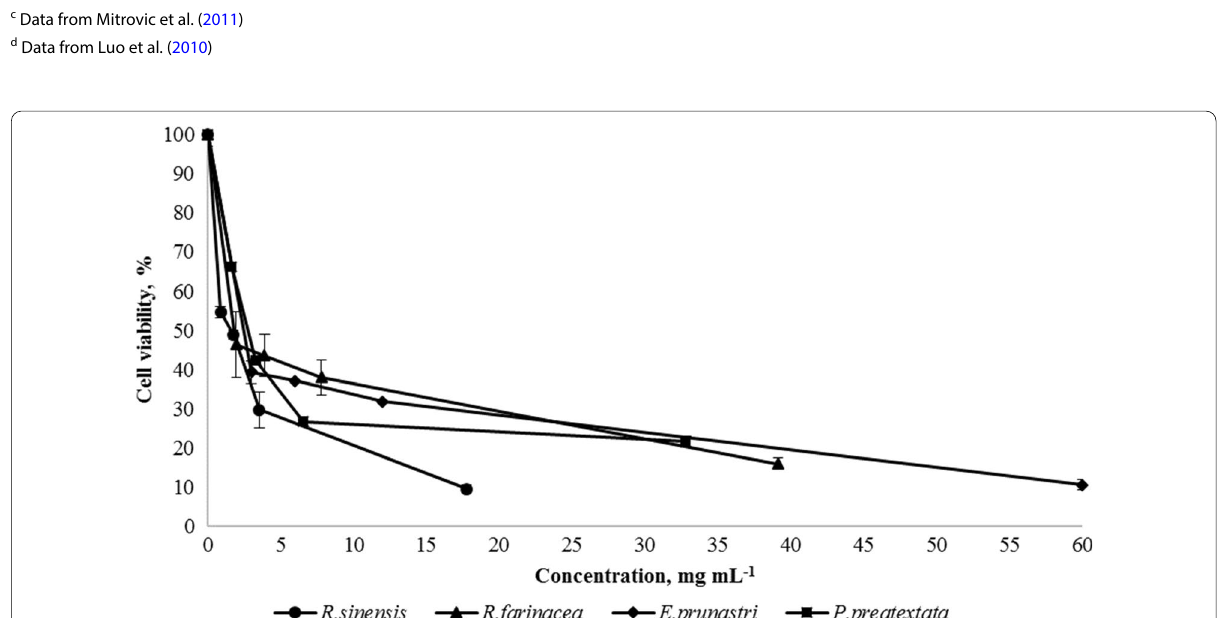
Fig. 2 Dose-dependent effects of methanol extracts of R. sinensis , R. farinacea , P. praetextata and E. prunastri on viability of HeLa